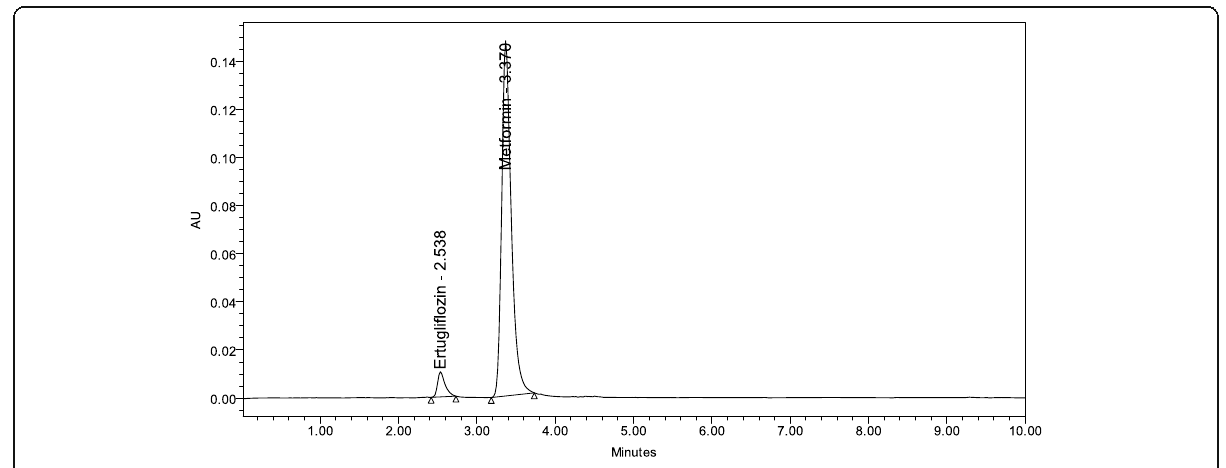
Fig. 11 Water chromatogram of Ertugliflozin and